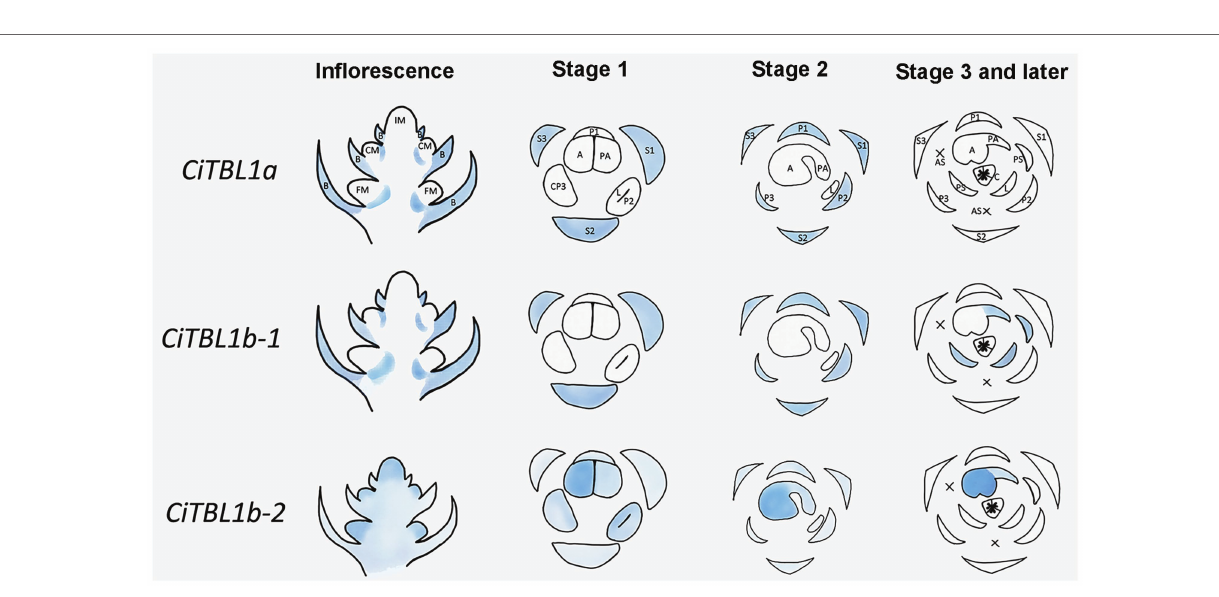
FIGURE 5 | Summary for the expression patterns of CiTBL1a , CiTBL1b-1 , and CiTBL1b-2 in the young inflorescence and flowers of different developmental stages. The positions with expression are shaded in blue. The darkness of the blue shades indicates the expression level.